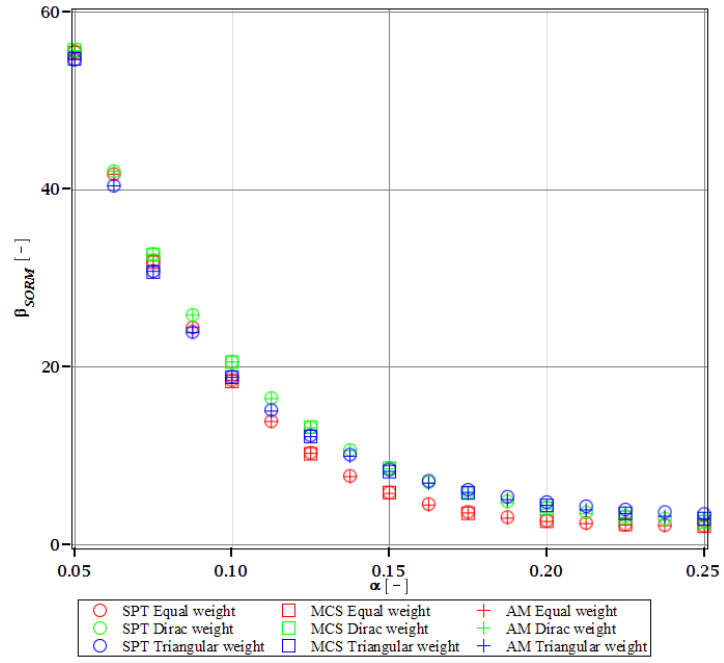
Figure 15. Reliability index of the corrugated I-beam for different types of weights according to the second-order reliability method (SORM) — eigenfrequency.